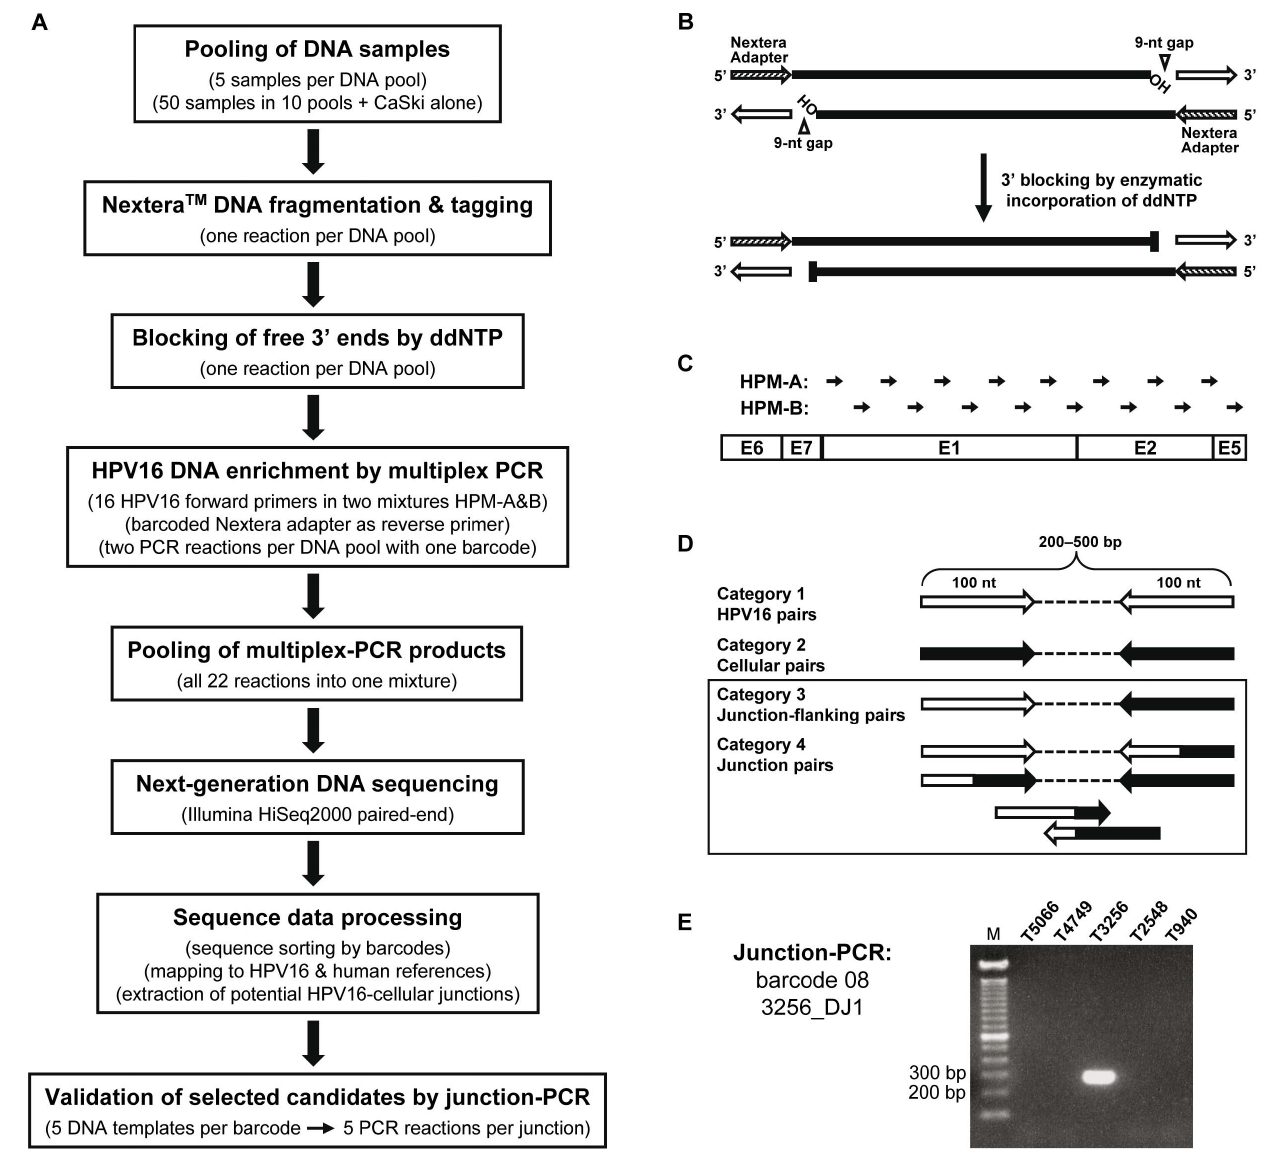
Figure 2. The TEN16 strategy for simultaneous determination of HPV16 DNA integration sites in multiple samples. (A) The TEN16 workflow. Details of the individual steps are given in parentheses. (B) Structure of DNA fragments produced by Nextera reaction and blocking of the DNA 3 9 -ends. DNA fragmented by Nextera transposition carries a 19-nt universal adapter (striated arrow; referred to as Nextera adapter) covalently coupled to the 5 9 -end of each strand, whereas a 9-nt gap separates the 3 9 -end from the complementary oligonucleotide (open arrow) [52]. In a PCR using Nextera DNA fragments as templates, DNA polymerase will repair the 9-nt gap. This will lead to whole-genome amplification if the Nextera adapter is used as a primer. For this reason, a blocking reaction with ddNTP was conceived to make the 3 9 -OH groups inaccessible for gap repair to reduce the amplification primed by Nextera adapter alone. (C) Enrichment of the HPV16 early region by multiplex PCR. Sixteen HPV16 forward primers assembled in two mixtures (HPM-A and -B) are used to cover the E1-E2-E5 region, where the viral 3 9 breakpoints can occur. The approximate primer locations are marked by arrows. (D) Categories of HiSeq2000 read pairs after sorting and mapping. In category 1 both reads of the same pair contain HPV16 sequences (open arrow) only, and in category 2 cellular sequences (filled arrow) only. Category 3 contains pairs with one HPV16 read and a cellular mate. Category 4 contains pairs with one junction read (combined arrow) plus an HPV16, a cellular, or a junction mate. Categories 3 and 4 are important for HPV16 integration site determination. (E) Validation of potential HPV16-cellular junctions by junction-specific PCR. The five DNA samples sharing the same barcode are used individually as PCR templates, and only one of them should be positive for the junction being tested. Shown here is the junction-PCR for the five DNA samples of barcode 08 and the positive result for 3256_DJ1. primer sequences are given in Table S1. With an estimated yield enough to determine viral-cellular junctions against the back- per lane of 100 million read pairs by HiSeq2000 sequencing, it was ground of pure HPV16 sequences. calculated that the simultaneous analysis of 50 samples in one To simplify the whole experimental procedure and to reduce TEN16 experiment would result in a sequencing depth of 125,000 the per-sample cost of Nextera, 50 DNA samples were partitioned read pairs per sample per HPV16 primer. This should be sensitive into ten pools (five samples each) before the Nextera reaction and